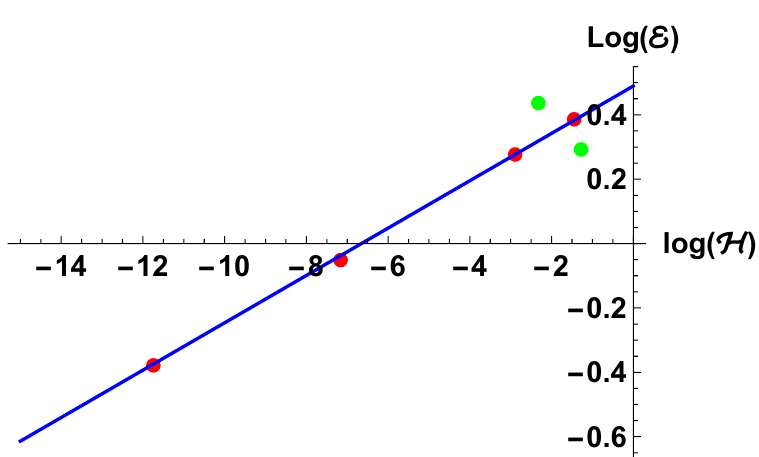
Figure 2. A log-log plot of E vs. H . The values are those in table 3. The red dots are (ave) the geometries A, B, C, D and the green dots are the pincers (1 , 0) , (2 , 1) . The blue line is the best-fit linear regression for these six points, given by y = 0 . 49 + 0 . 07 x with statistical parameters R 2 = 0 . 950 and p = 9 . 5 × 10 − 4 . (The fit without the two pincer datapoints gives approximately the same line with R 2 = 0 . 9997 and p = 1 . 6 × 10 − 4